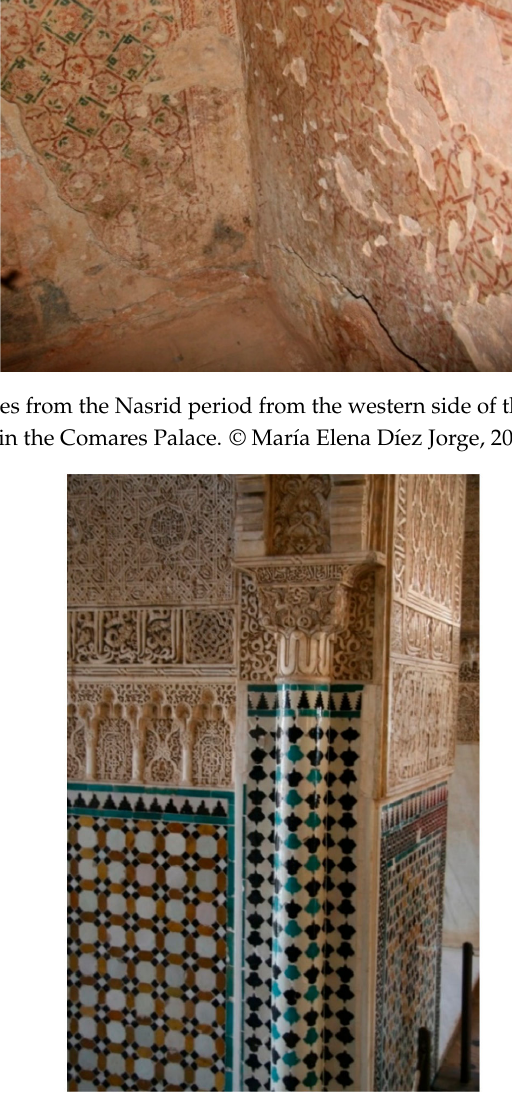
Figure 8. Columns faced with alicatado pieces, cut in a curve. Comares Palace, 14th century. © Mar í a Elena D í ez Jorge,